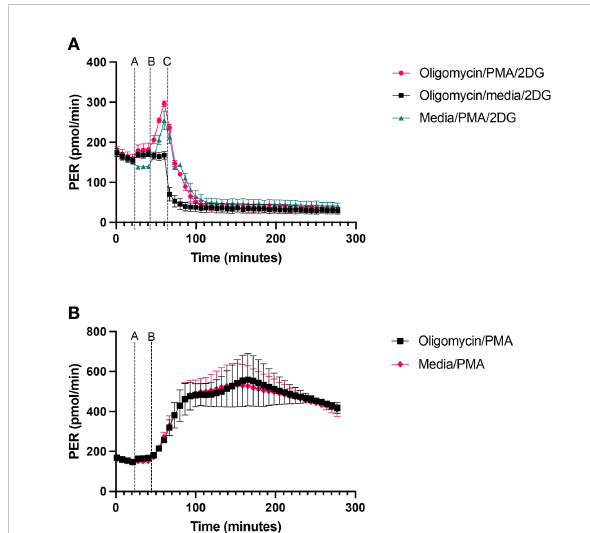
FIGURE 5 PER from neutrophils exposed to oligomycin or PMA. Human peripheral blood neutrophils were seeded at a density of 2 x 10 5 cells/well onto a Cell-Tak ™ coated XFe96 microplate. (A) 2 µM oligomycin or XF media was injected fi rst, followed by sequential injections of 160nM PMA or XF media and fi nally 50 mM 2-Deoxy- D-Glucose (2-DG) at de fi ned time points as shown on the fi gure. (B) 2 µM oligomycin or XF media was injected fi rst, followed by 160nM PMA. Extracellular acidi fi cation rate (ECAR) was measured across the duration of the test. Following data export, ECAR readings were